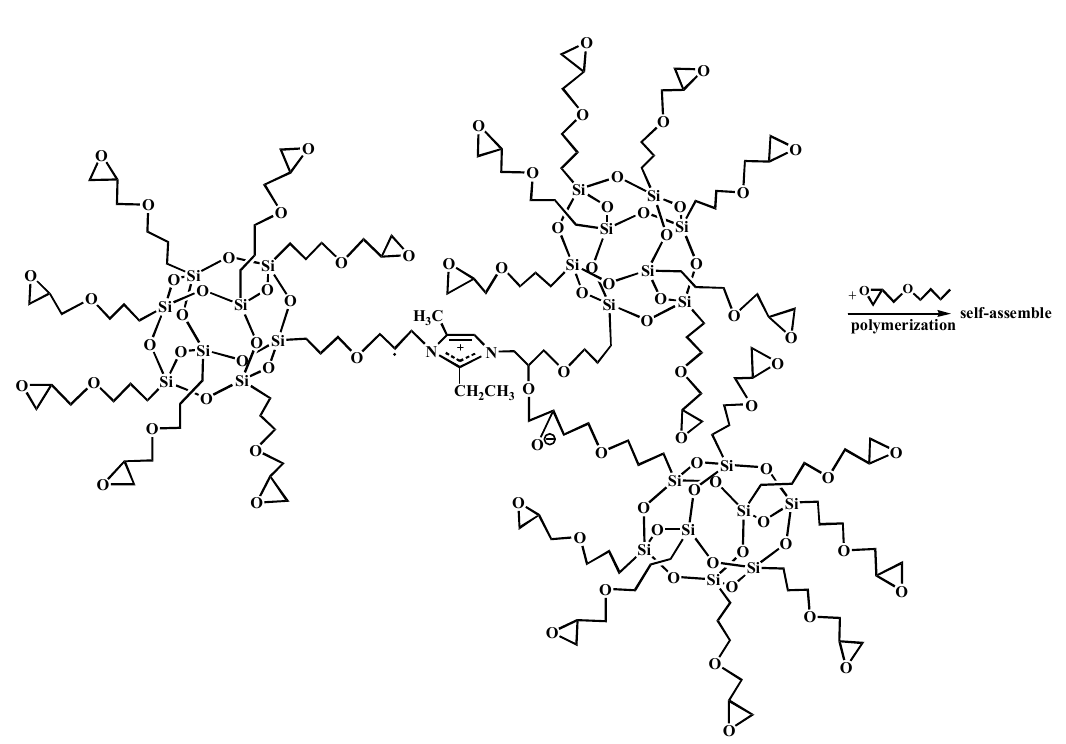
Figure 7. Self-assembly of glycidyl-POSS.